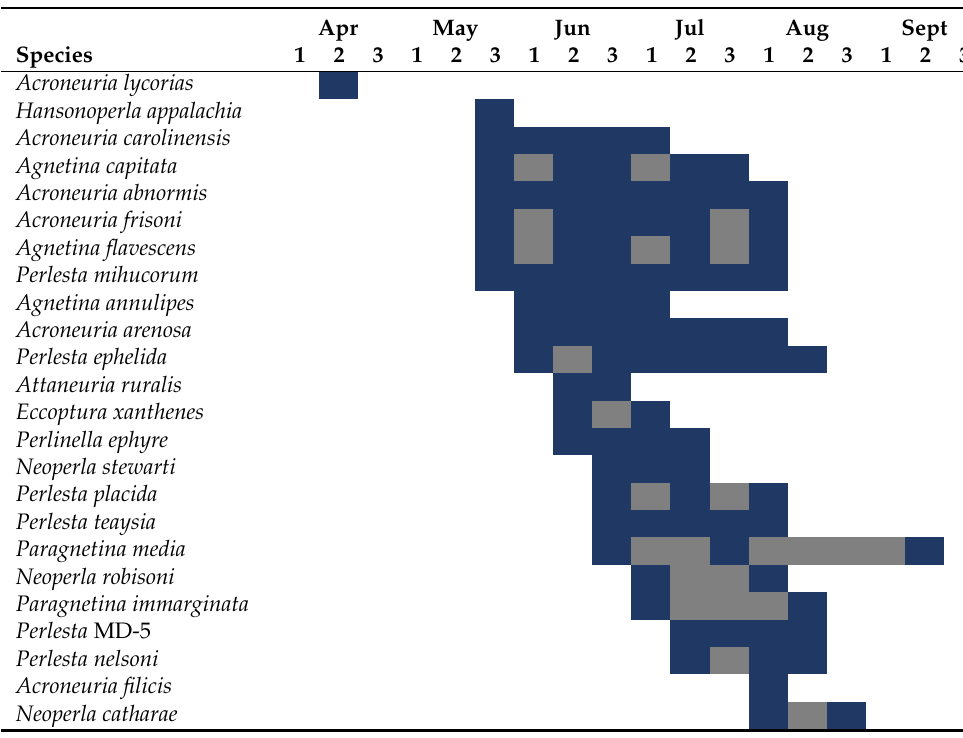
Table 9. Recorded adult Perlidae presence in Maryland. Months are broken into three 10-day periods. Dark blue squares represent periods with collections. Gray squares represent periods when species may be collected.